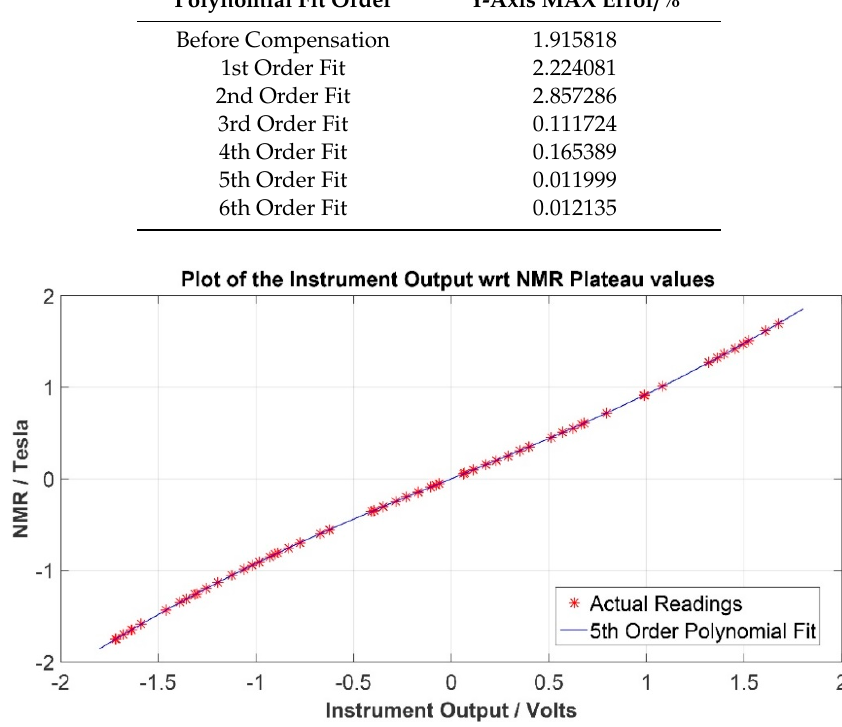
Figure 6. Graph showing the actual mean output response of the instrument at each set NMR plateau and the fit obtained using a 5th order polynomial.